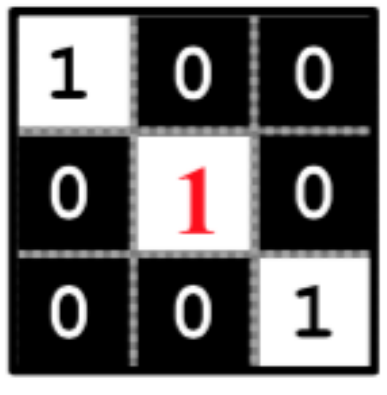
Figure 7. Structure